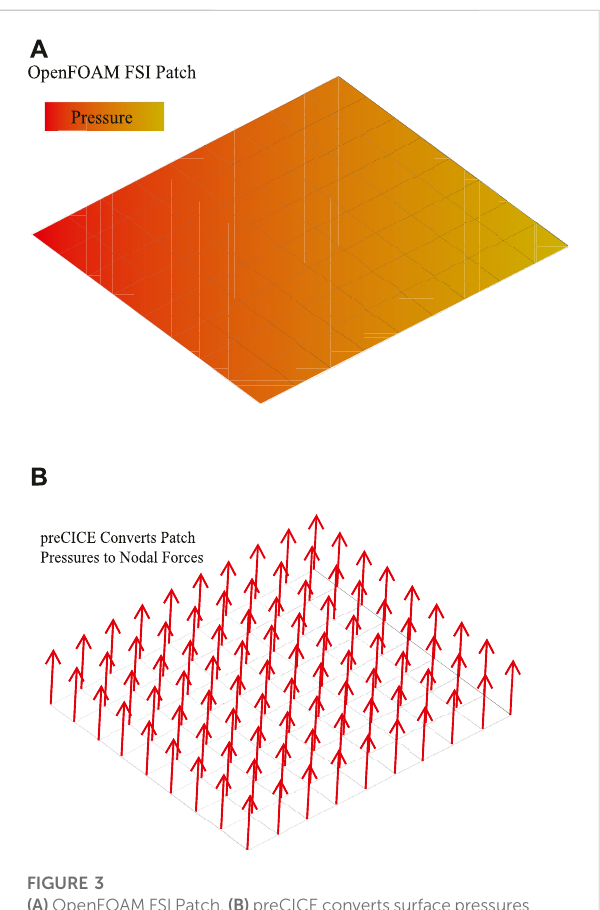
FIGURE 3 (A) OpenFOAMFSIPatch. (B) preCICEconvertssurfacepressures along the FSI patch into nodal forces which may then be mapped to branch nodes.